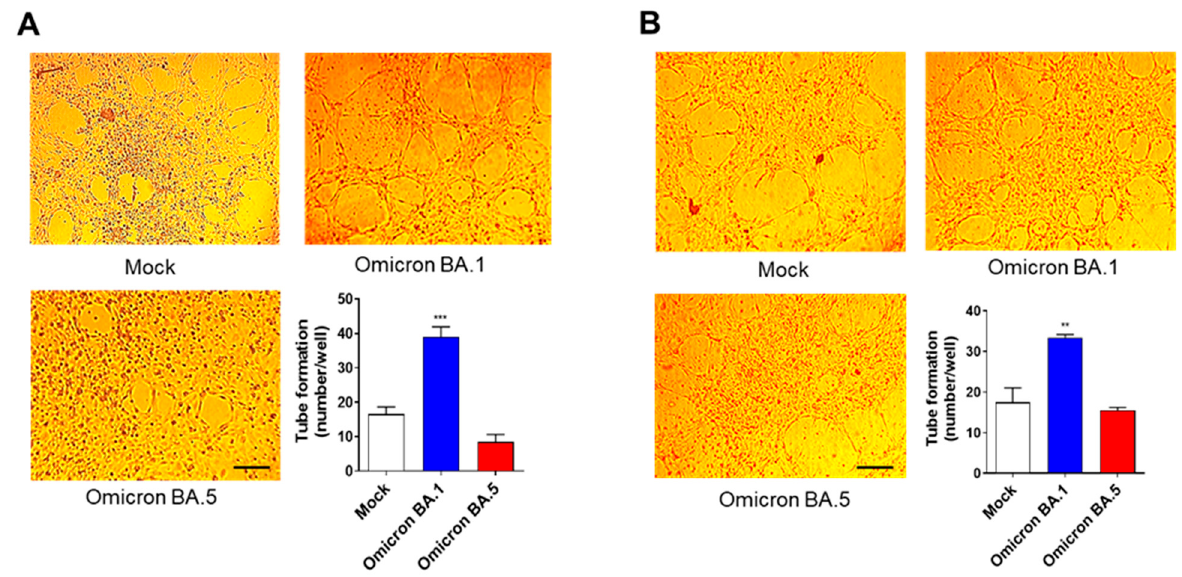
Figure 5. SARS-CoV-2 BA.5 does not trigger angiogenic functions. ( A ) HL-mECs were mock-infected (Mock) or infected with SARS-CoV-2 belonging to Omicron BA.1 or BA.5 lineages (Omicron BA.1 and Omicron BA.5, respectively) at MOI 1, for 1 h at 37 ◦ C and then washed and cultured until day 3 p.i. Mock-, Omicron BA.1-, and Omicron BA.5-infected HL-mECs were seeded on reduced growth factor Matrigel-coated wells and then cultured for 12 h at 37 ◦ C. Pictures are representative of one out of three independent experiments with similar results (scale bar, 200 µ m). ( B ) Tube